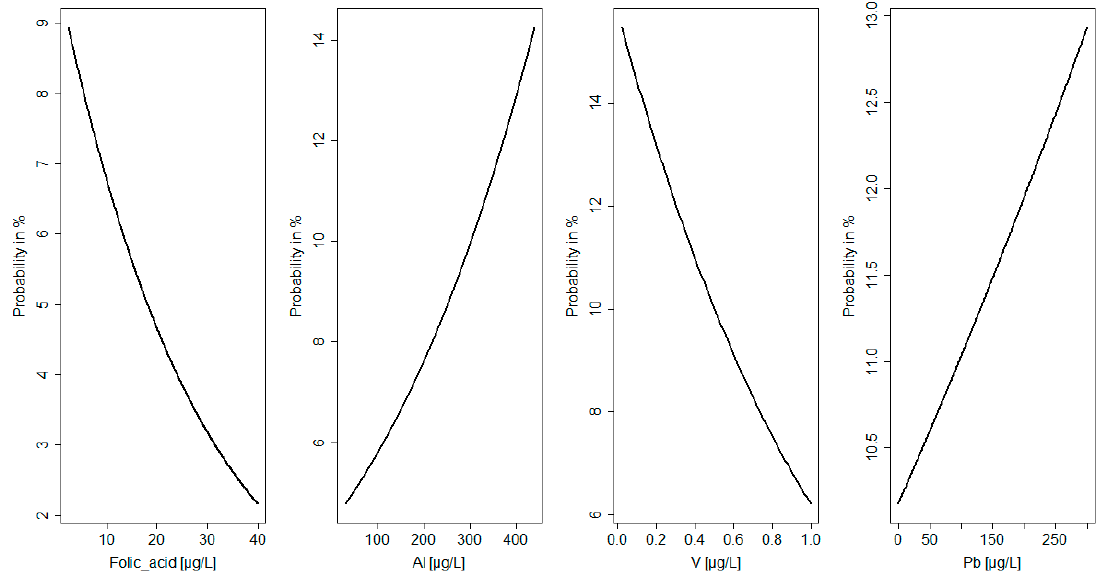
Figure 2. Probability of congenital abnormalities related to element and folate levels in amniotic fluid.